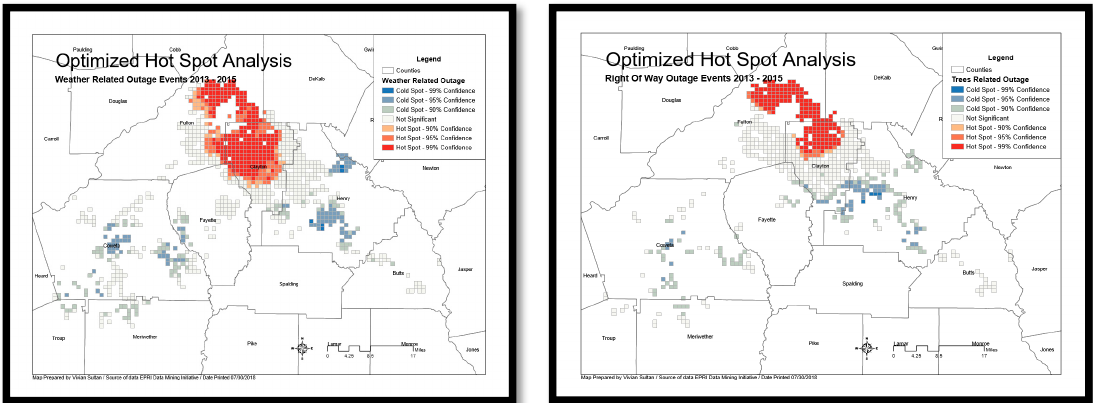
Figure 12. Spatial Analysis Level 2—Optimized Hot Spot Analysis output maps per type of outage causes. Top left : system overload; top right : equipment failure, bottom left : weather; bottom right : right of way.